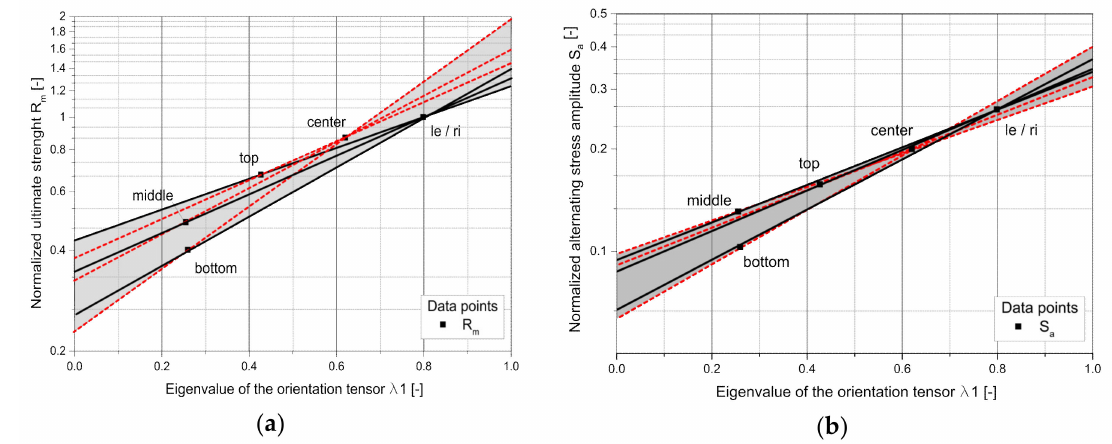
Figure 7. Influence of extraction position on the data set ( a ) ultimate strength ( b ) fatigue strength at N = 10 6 cycles. The gray shaded area thus spans the entire range of all possible combinations.